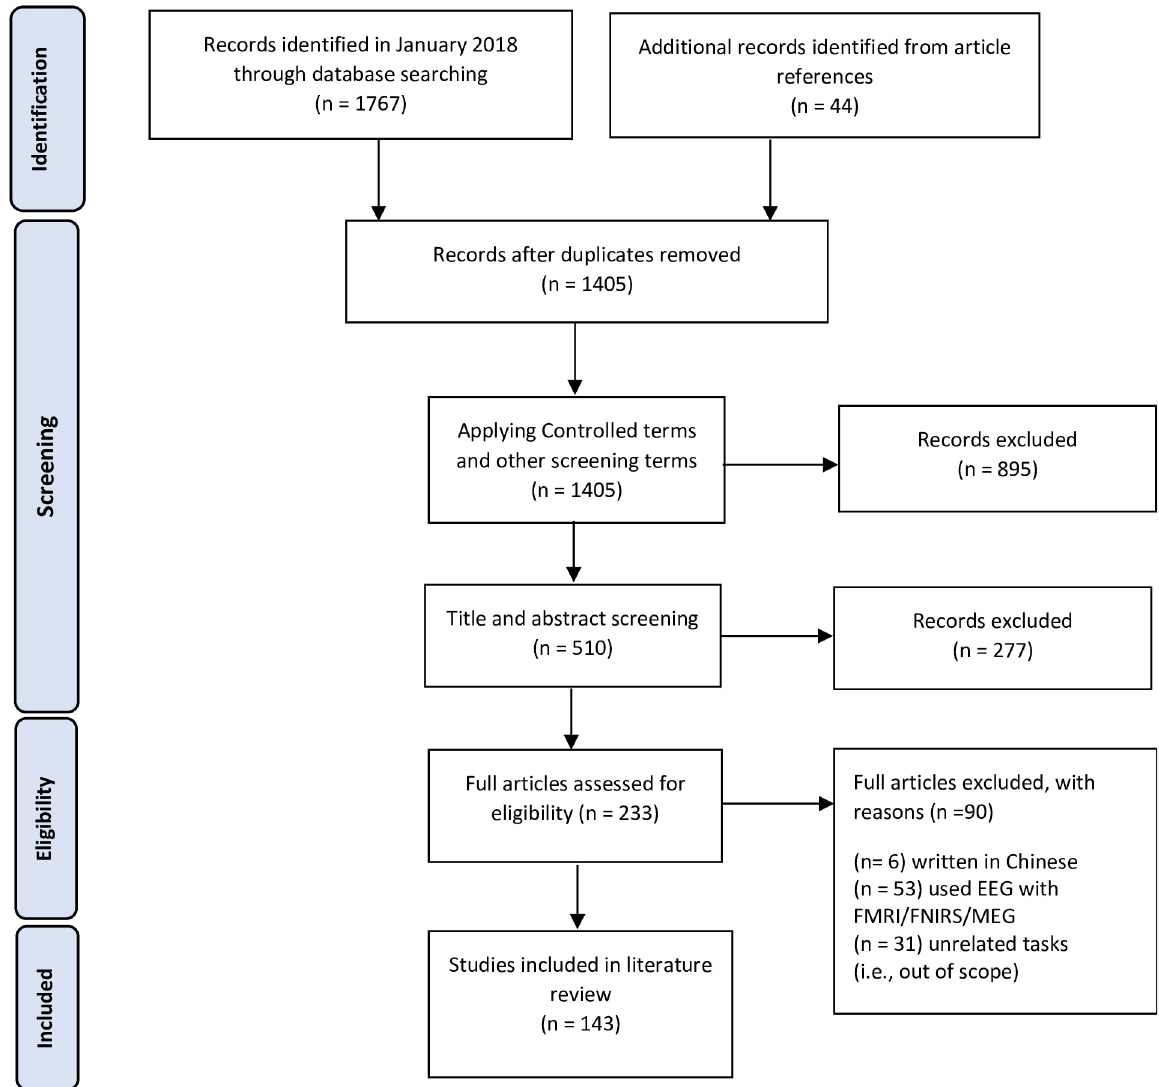
Fig 1. Selection process for the cognitive work studies included in the present review according to PRISMA guidelines.